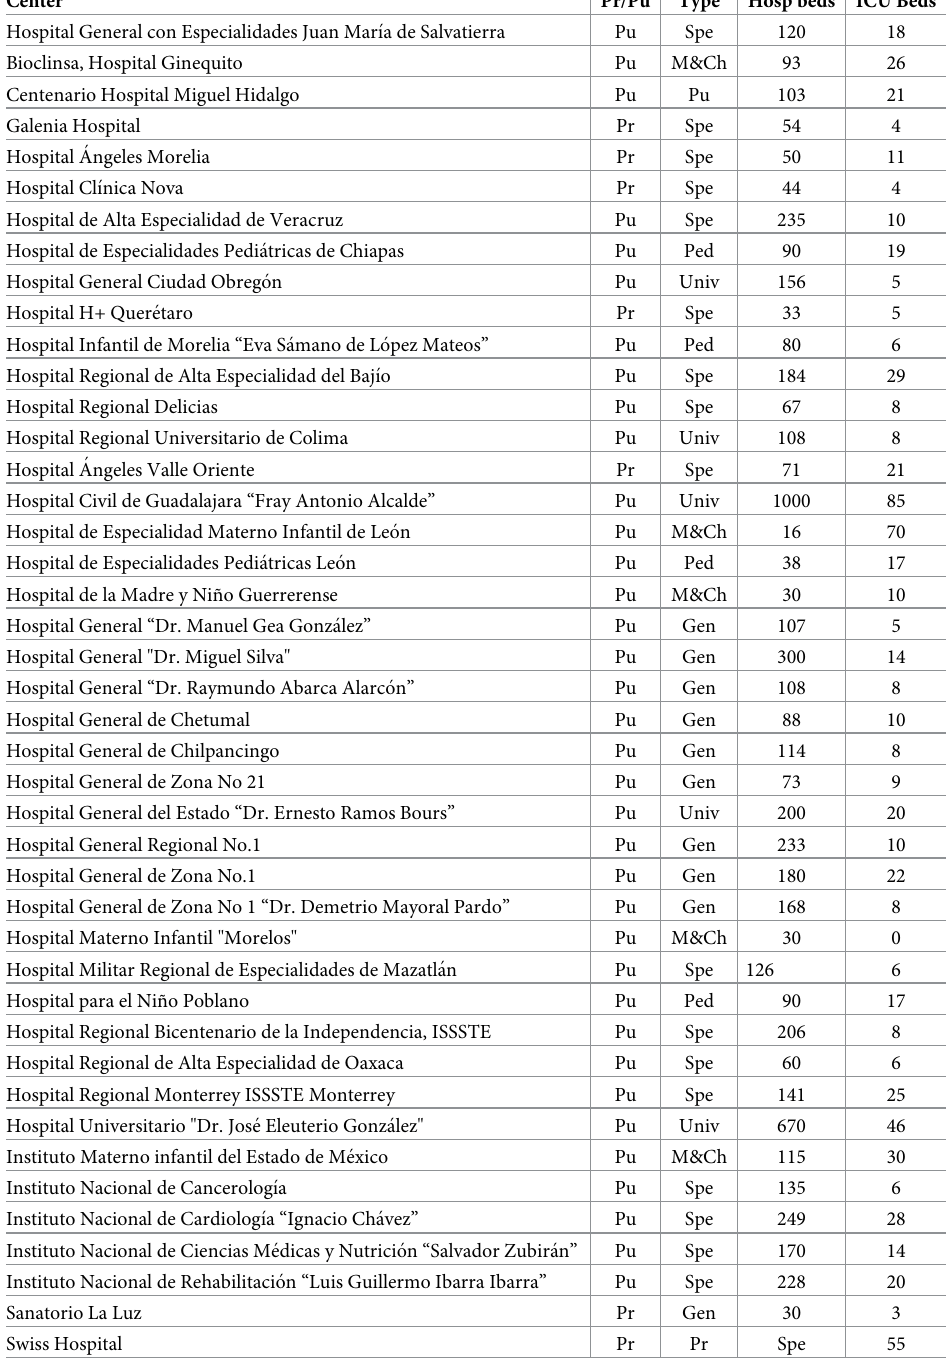
Table 1. Characteristics of hospitals